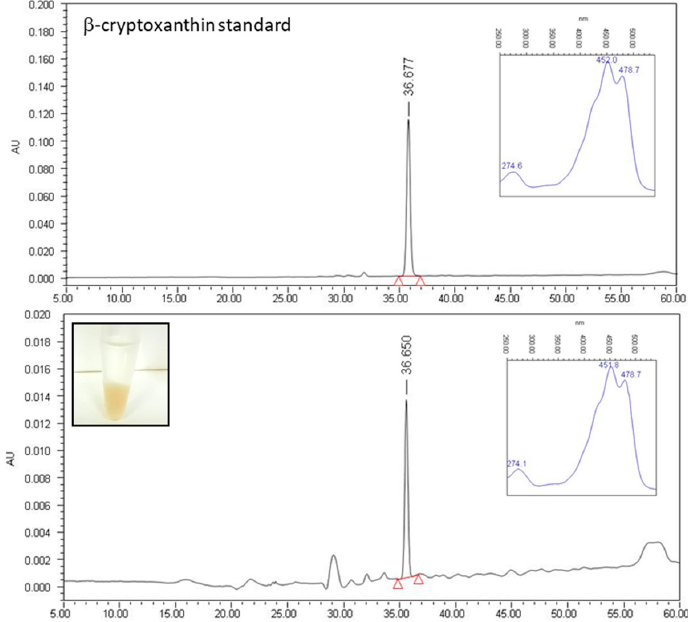
Figure 2. ( A ) BCX uptake by C. elegans . HPLC ‐ PAD (High Performance Liquid Chromatography ‐ Photodiode Array Detector) chromatograms of BCX ( β‐ Cryptoxanthin) standard; ( B ) pellet extract from worms previously fed with BCX at 1 μ g/mL; and ( C ) from worms grown under control condition (NGM (Nematode growth medium) without supplementation). Insert plots in ( A , B ) show the absorbance spectrum of the carotenoid peak identified in the chromatograms. Insert images in ( B , C ) show the corresponding worm pellets before disruption showing the differences in coloration. AU, arbitrary absorbance units. One important source of BCX in the human diet are mandarins which is esterified with a variety of fatty acids in a high proportion [8,12]. Analysis of carotenoid composition in the juice extract of Clementine mandarin showed that BCX was the main carotenoid accounting for nearly 60% of the total carotenoid content and being 90% in esterified form (Table 1). As expected, the mandarin extract also contained significant amounts of other β , β‐ xanthophylls (violaxanthin, zeaxanthin, and antheraxanthin), as well as β‐ carotene and colorless carotenes (phytoene and phytofluene) (Table 1). To investigate whether carotenoid esterification with fatty acids may have an impact on the reduction of lipid content in the nematode, the reduction in body fat was determined in nematodes fed with a non ‐ saponified carotenoid extract from mandarin juice and compared with that of a saponified extract. Aliquots of free (saponified) or esterified (non ‐ saponified) carotenoid extracts from mandarin juice were prepared to adjust the BCX to a final concentration of 0.025 μ g/mL and the effect on worm body fat reduction was determined (Figure 3). Both types of extracts provide a significant reduction of fluorescence respect control medium (30.66% and 31.38%,